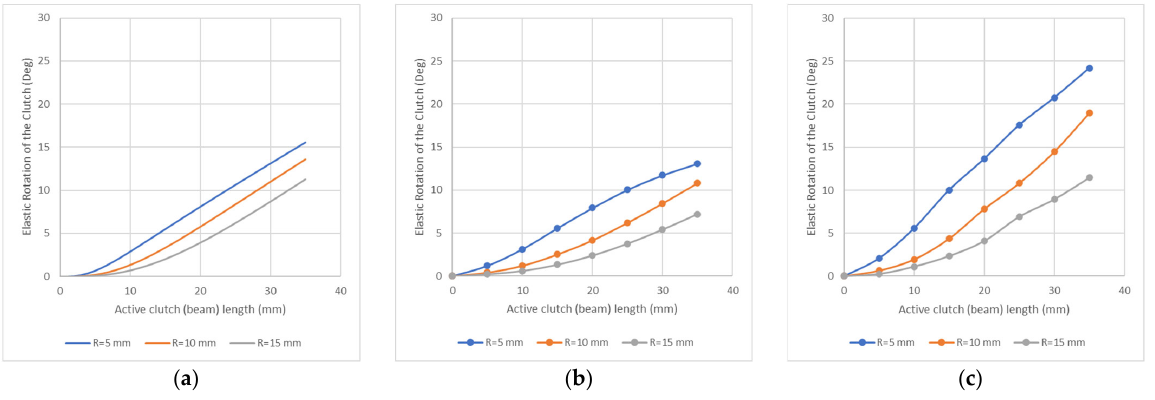
Figure 8. Elastic rotation of the joint versus active clutch length (Moment = 0.5 Nm). ( a ) Analytical results, ( b ) numerical results, and ( c ) experimental results.